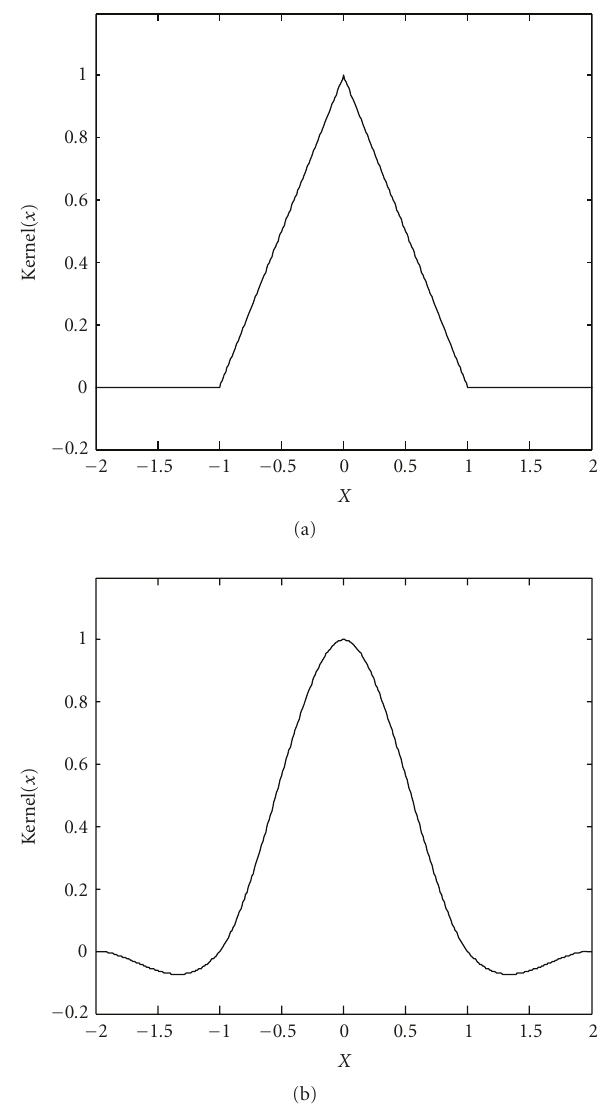
Figure 3: Two conventional 1D interpolation kernels. (a) The linear interpolation. (b) The cubic interpolation.